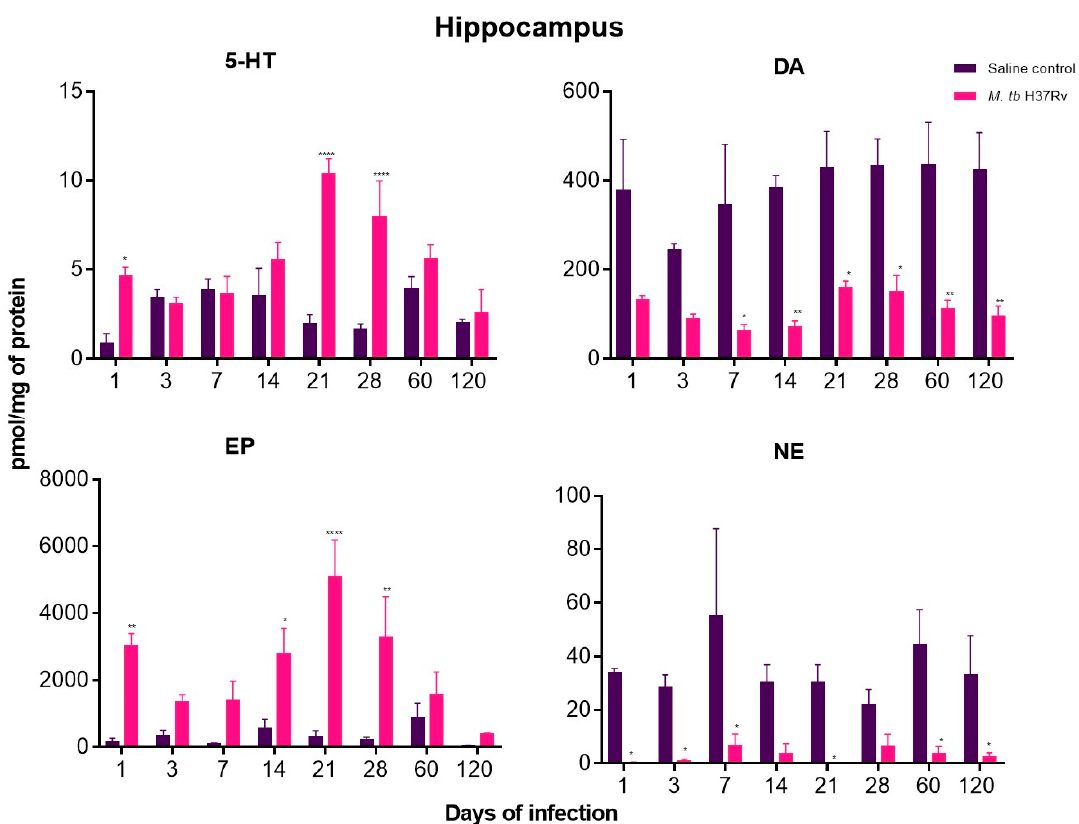
Figure12. TheconcentrationoftheindicatedneurotransmitterdeterminedbyHPLCinthehippocampus of animals intratracheally infected with M. tb . Pulmonary TB mice showed a significant increase in EP from day one of infection and a decrease in the concentration of DA and NE. Data are expressed as mean ± SEM. The following were used: 5-HT F (1, 6) = 74.16, p = 0.0001, two-way ANOVA; * p < 0.01, **** p < 0.0001, Sidak’s multiple comparisons test ( α = 0.05) ( n = 6). DA F (1, 6) = 60.82, p = 0.0002, two-way ANOVA; * p < 0.01, ** p < 0.001, Sidak’s multiple comparisons test ( α = 0.05) ( n = 6). EP F (1, 6) = 38.81, p = 0.0008, two-way ANOVA; * p < 0.01, ** p < 0.001, **** p < 0.0001, Sidak’s multiple comparisons test ( α = 0.05) ( n = 6). NE F (1, 6) = 35.01, p = 0.0010, two-way ANOVA; * p < 0.01, Sidak’s multiple comparisons test ( α = 0.05) ( n =